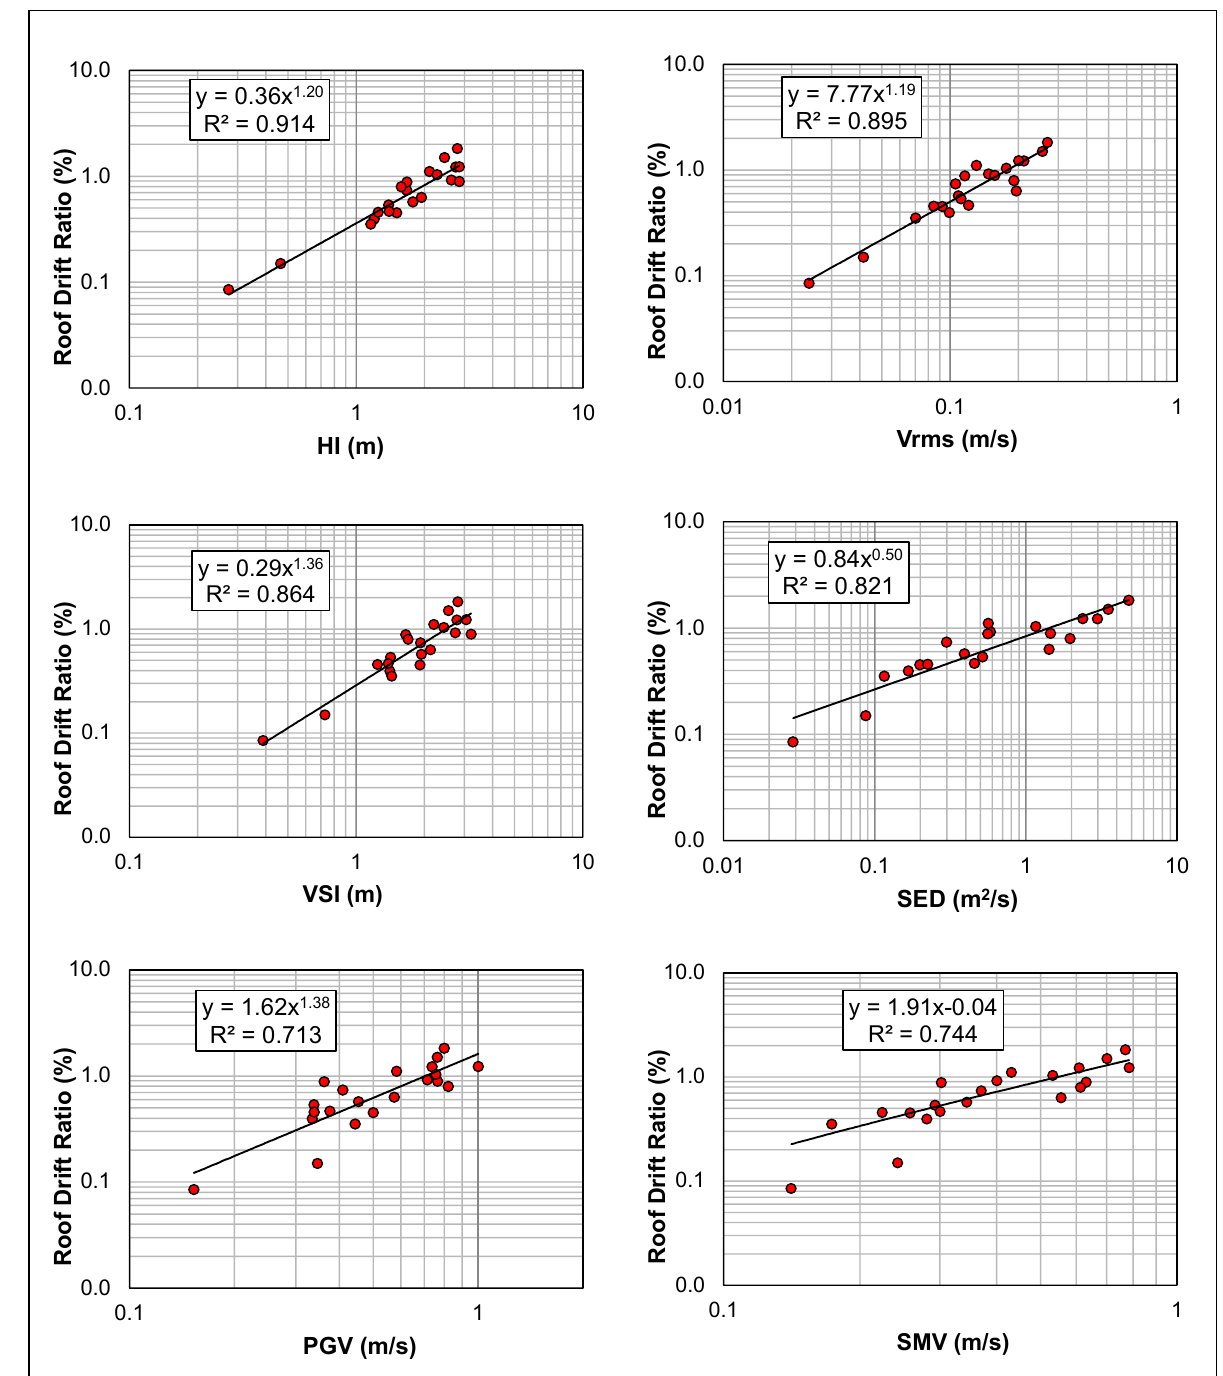
Figure 11. The correlation for the average roof drift ratio (RDR) of building models versus velocity related parameter values of the ground motion parameters.